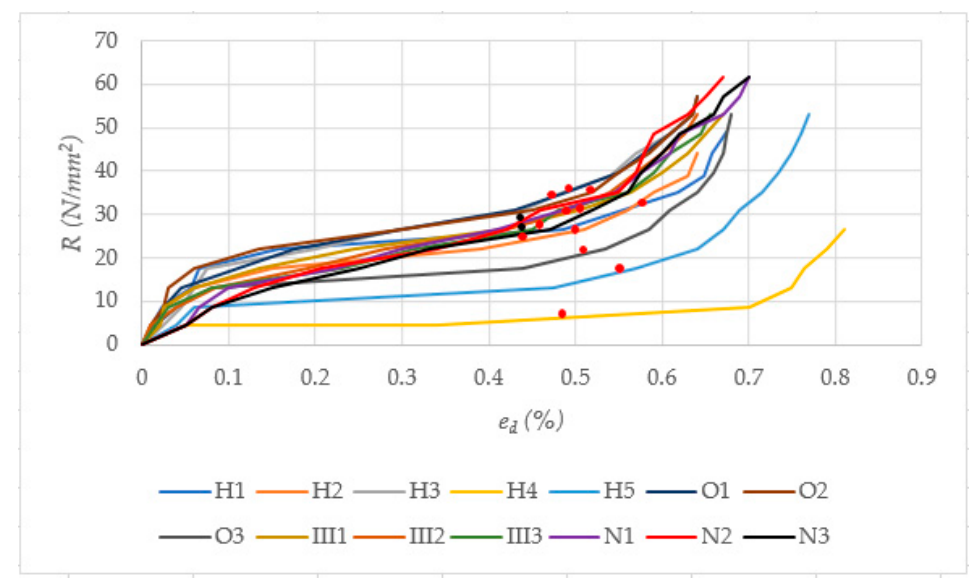
Figure 11. Stress–strain curves of all samples.